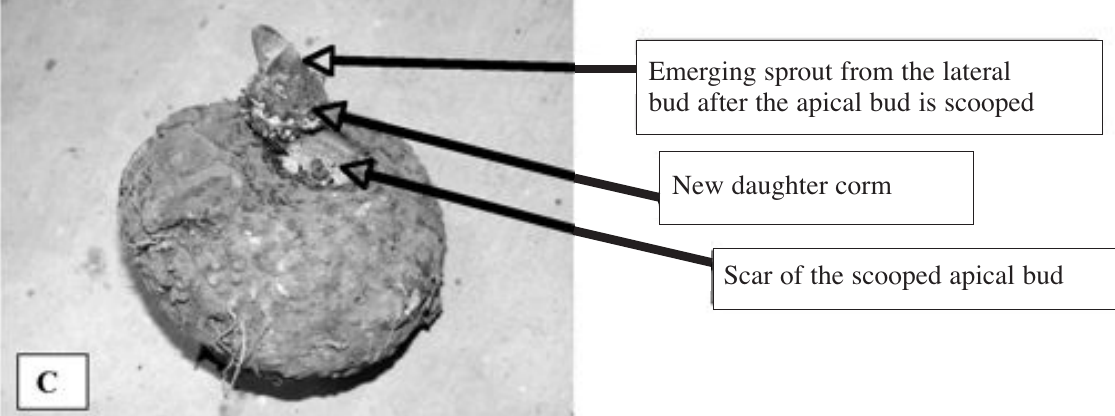
Fig. 5 - Emerging sprout from the lateral bud after the apical bud is